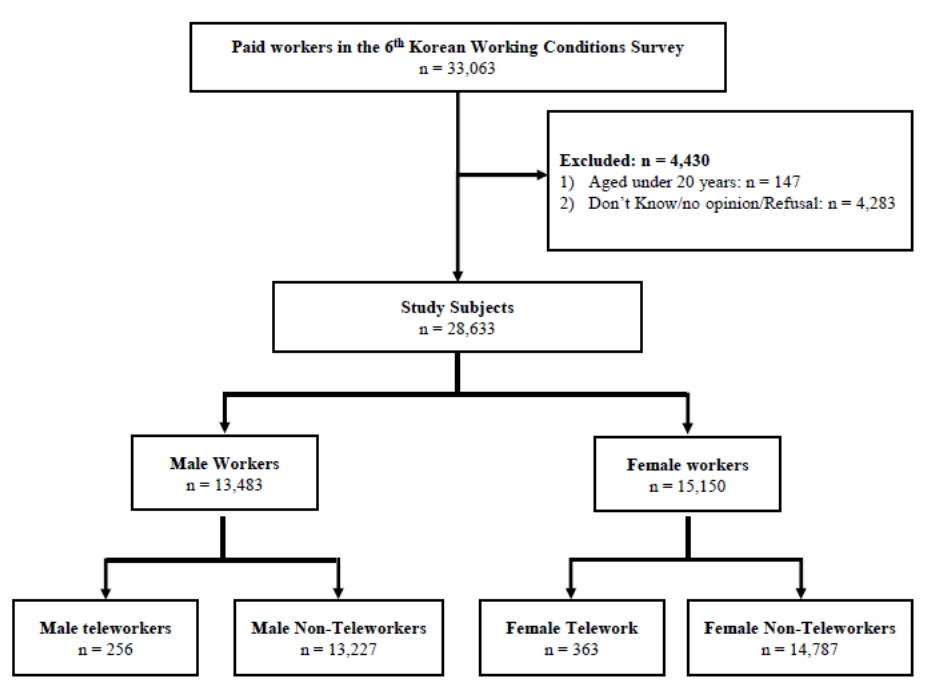
Figure 1. Schematic flow of participant selection process.